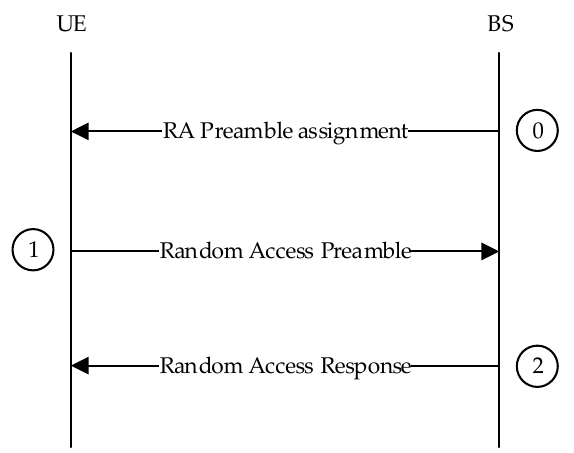
Figure 2. Contention-free random access procedure.